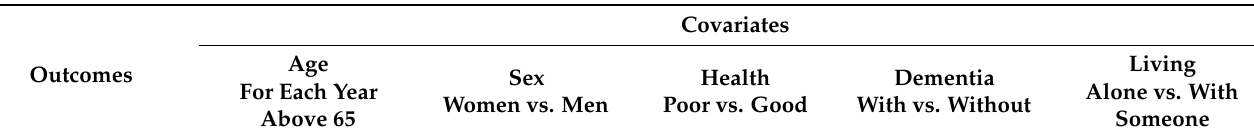
Living Alone vs. With